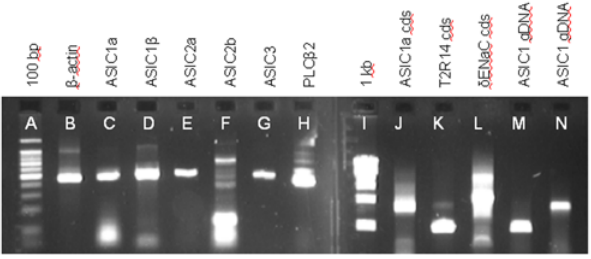
Figure 4. RT-PCR and genomic analysis of gene expression in sour-normal subjects. Transcripts for all ASICs tested are clearly detectable, as also are those for housekeeping and taste-related genes. Lane identifications: (A) 100 bp DNA marker, with the brightest band being 500 bp; (B) Transcript for 460-bp fragment of b -actin in a pooled sample of fungiform papillae from Subjects 45 and 49; (C–G) Transcripts for, respectively, ASICs 1a, 1 b , 2a, 2b (weakly-staining band at 467 bp in Lane 6), and ASIC3 in a pooled sample of fungiform papillae from Subjects 45 and 49; (H) Transcript for PLC- b 2 in Subject 49; (I) 1 kb DNA marker; (J) full coding sequence of ASIC1a of